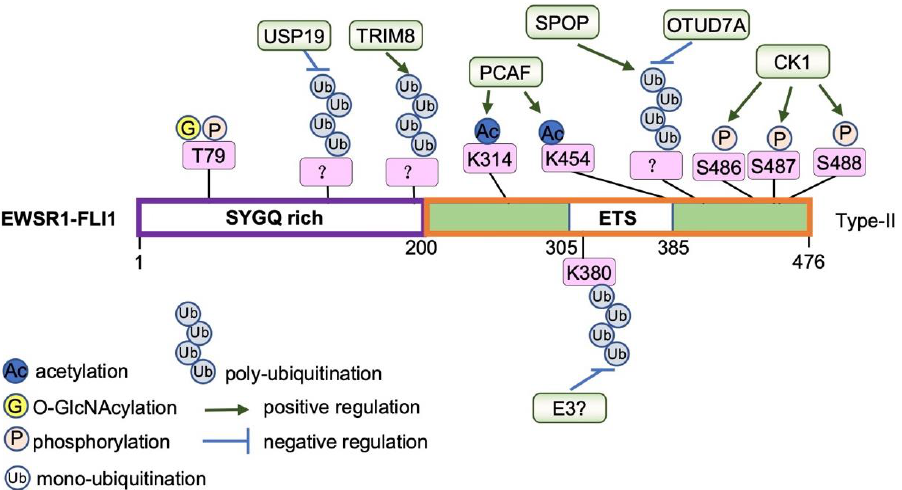
Figure 2. A summary of EWSR1-FLI1 post-translational modifications. Function of EWSR1-FLI1 proteins are regulated by various post-translational modifications including mono-ubiquitination, poly-ubiquitination, phosphorylation, acetylation and O-GlcNAcylation in cells as indicated